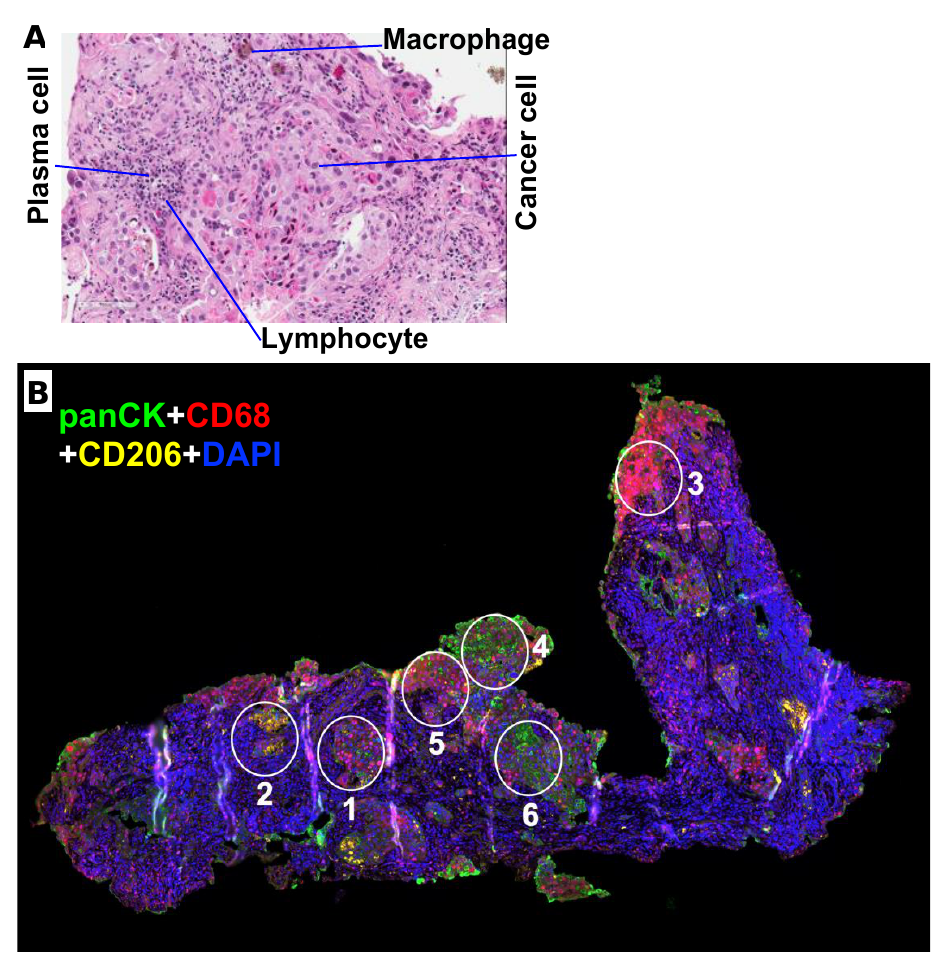
Figure 1. Heterogenous cellularity in organotypic tissue cultures (OTC) of non-small cell lung cancer (NSCLC) patient tumor tissues. The freshly resected NSCLC patient tumor tissues were thinly sliced and incubated in Dulbecco's Modified Eagle's Medium (DMEM) medium as OTC for 24 h at 37 °C/5% CO 2 before fixing in 4% buffered formalin, embedded in paraffin block, and sectioned into 4 µm slices for H&E staining in ( A ) and IF staining for cancer cells (panCytokeratin or panCK), CD8 (cytotoxic T cells), and CD68 (Mφ) in ( B ). Highly heterogeneous distribution of cancer cells and various immune cell types is evident. White circles (200 μm diameter) in ( B ) defined the regions of interest (ROI) for the ROI-specific analysis (DSP) of 58 different protein markers that reflect immune functions. Each ROI was enriched in CD8 T cells ( 3 ), Mφ ( 2 ), and cancer cells ( 4 , 6 ), or contained a mixture the three cell types ( 1 , 5 ).